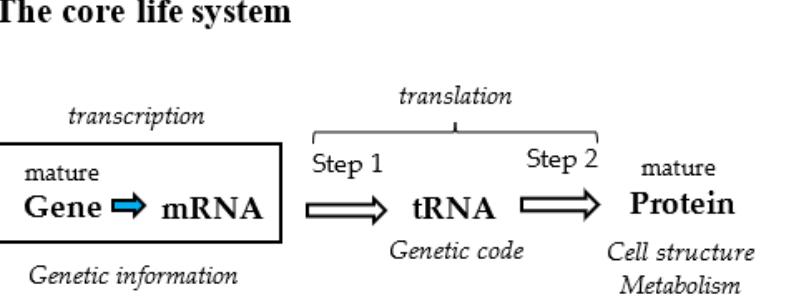
Figure 1. The core life system composed of four members, gene, tRNA (genetic code), and protein. tRNA and genetic code, which are underestimated in Central dogma, are brought to the surface in the core life system (Ikehara, 2021 [1]).